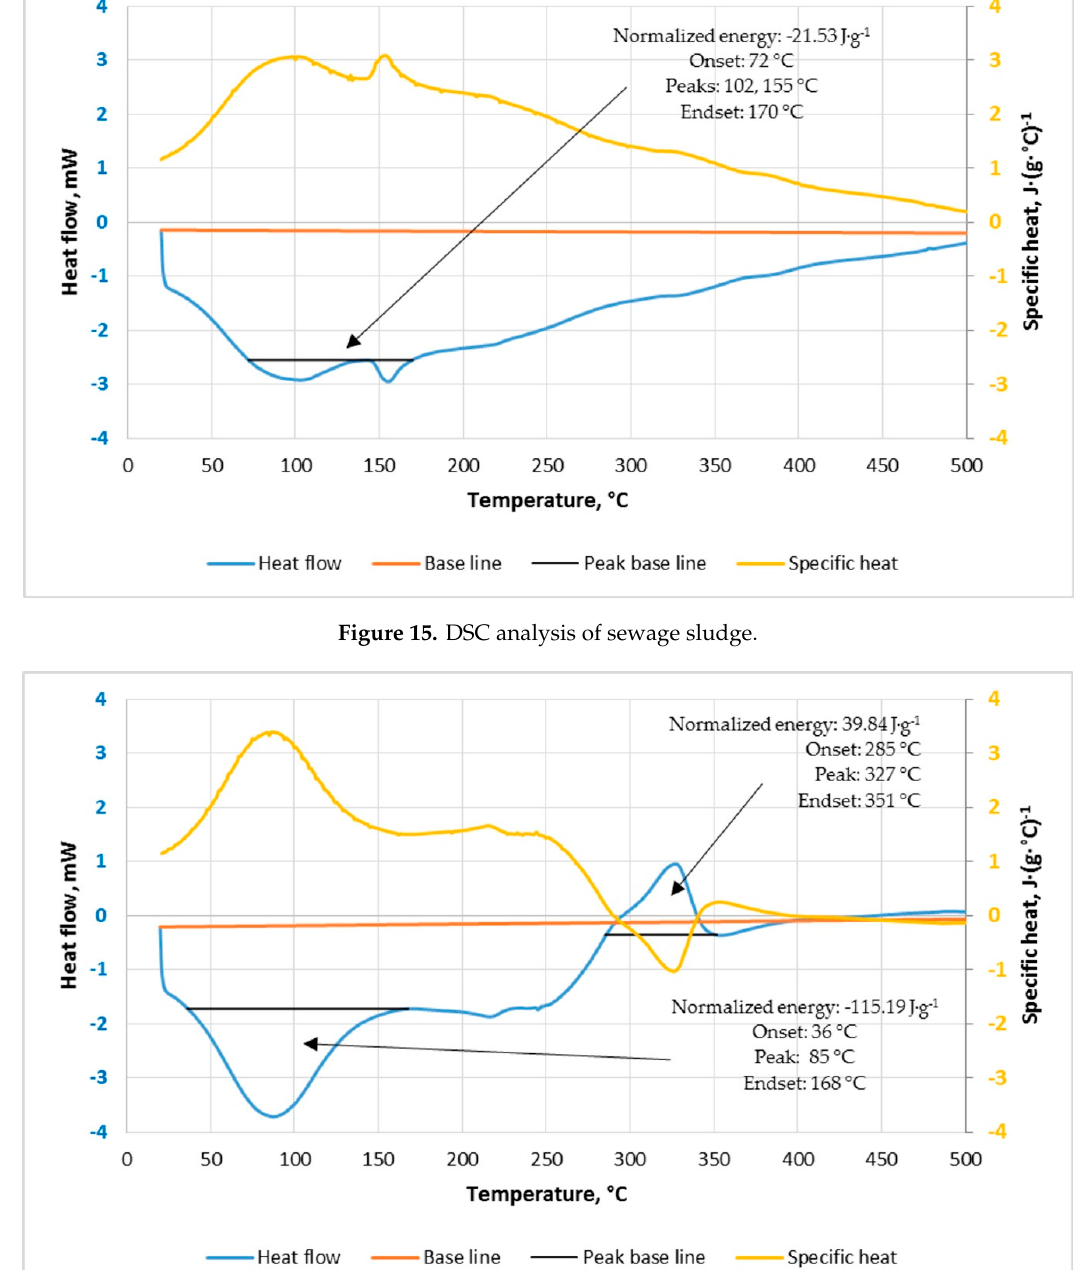
Figure 16. DSC analysis of digestate.